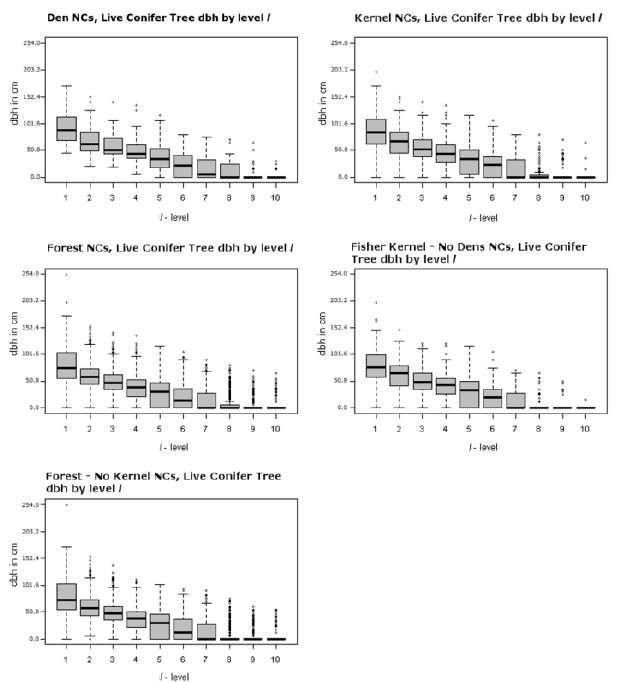
Figure 5. Largest dbh conifer tree in plot level l for each quadrature distribution from left to right: Den, Kernel, Forest, Kernel excluding den NCs, and Forest excluding kernel NCs. Solid bar represents the median, gray box represents the 25% quartile above and below the mean, and the whiskers represent 3.5 times the upper and lower values of the gray box. The dots are individual values that lie outside the whiskers.